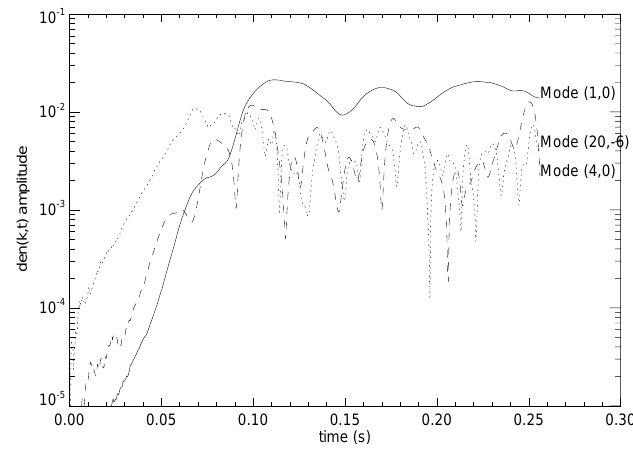
Fig. 10. n i ( k ,t) vs. time for two modes, the solid line shows the (1,0) mode which is at k = ( 2 π/ 41 , 0 ) m − 1 , the dotted line shows the (20, − 6) mode at k = ( 2 π/ 2 . 0 , 2 π/ 6 . 8 ) m − 1 and the dashed line shows the (4,0)